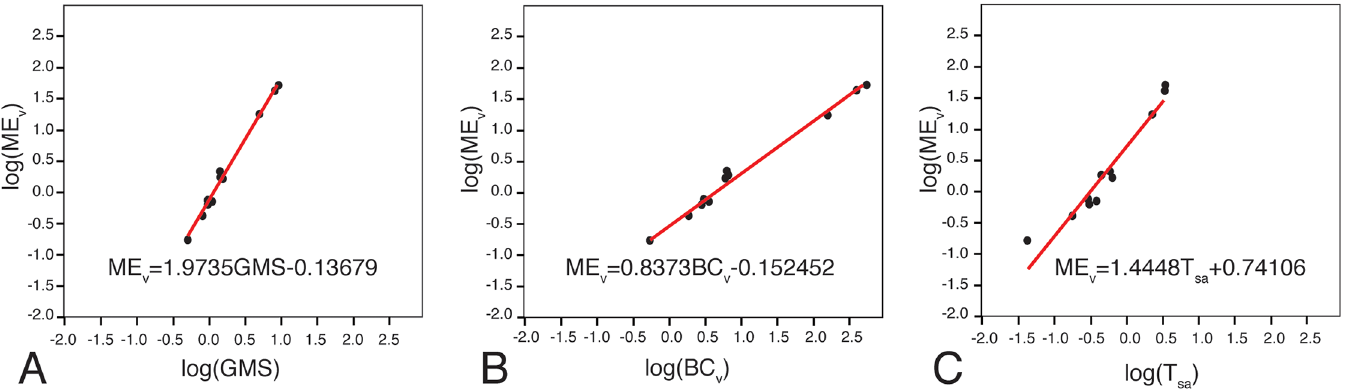
Fig 14. Comparisons of reduced major axis (RMA) regressions for middle-ear volume regressed onto A) skull size, B) braincase volume, C) tympanum surface area. BC v = braincase volume; B v = brain volume; GMS = geometric mean of skull-size measurements; M ev = middle-ear volume; T sa = tympanum surface